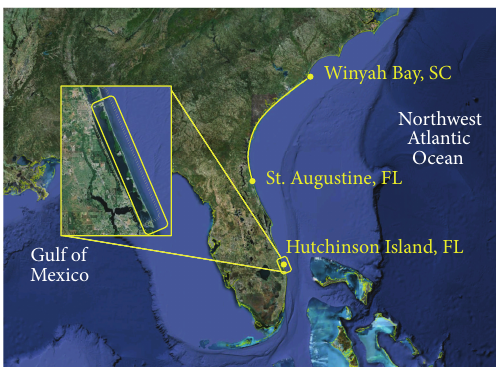
Figure 1: Map showing location of sample collection sites. Samples were collected from turtles captured in water from Winyah Bay, SC to St. Augustine, FL. Samples from nesting females were collected on Hutchinson Island, FL. Image from Google Maps (© 2013 Google